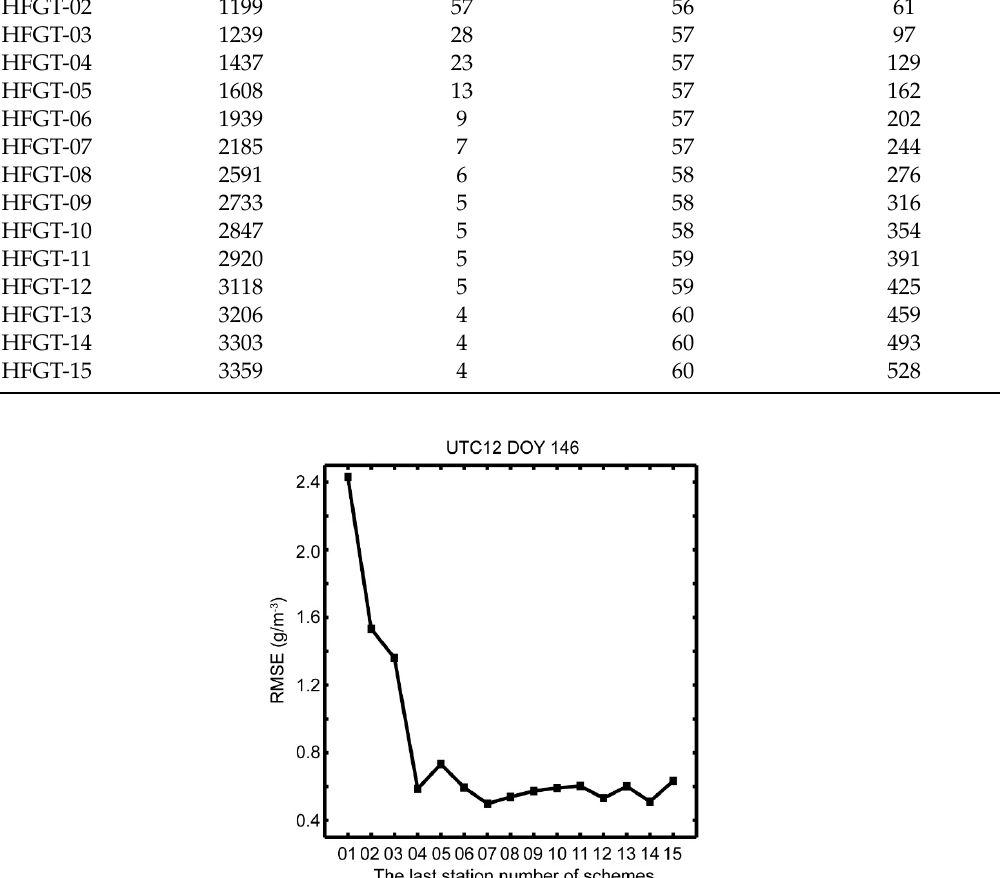
Figure 12. RMSE (black squares) of the fifteen GNSS tomographic schemes at UTC 12 on days of year (DOY) 146; HKKP’s radiosonde data were used as the reference.